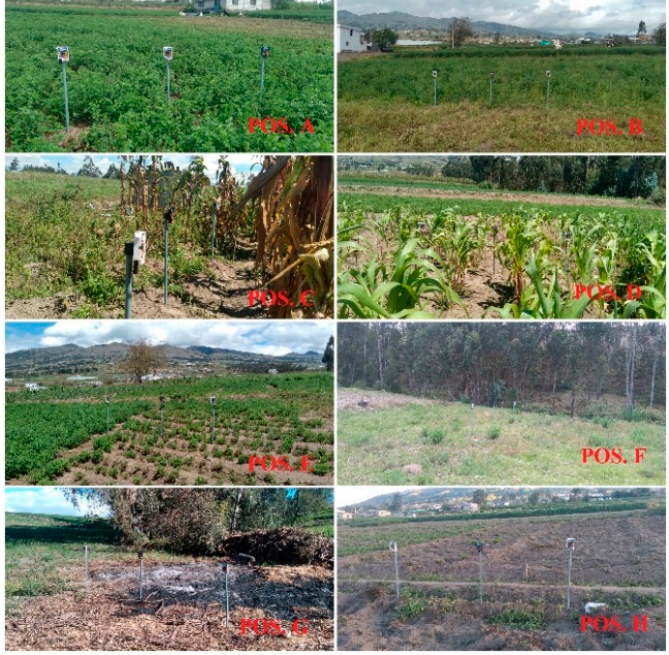
Figure 10. End nodes in test